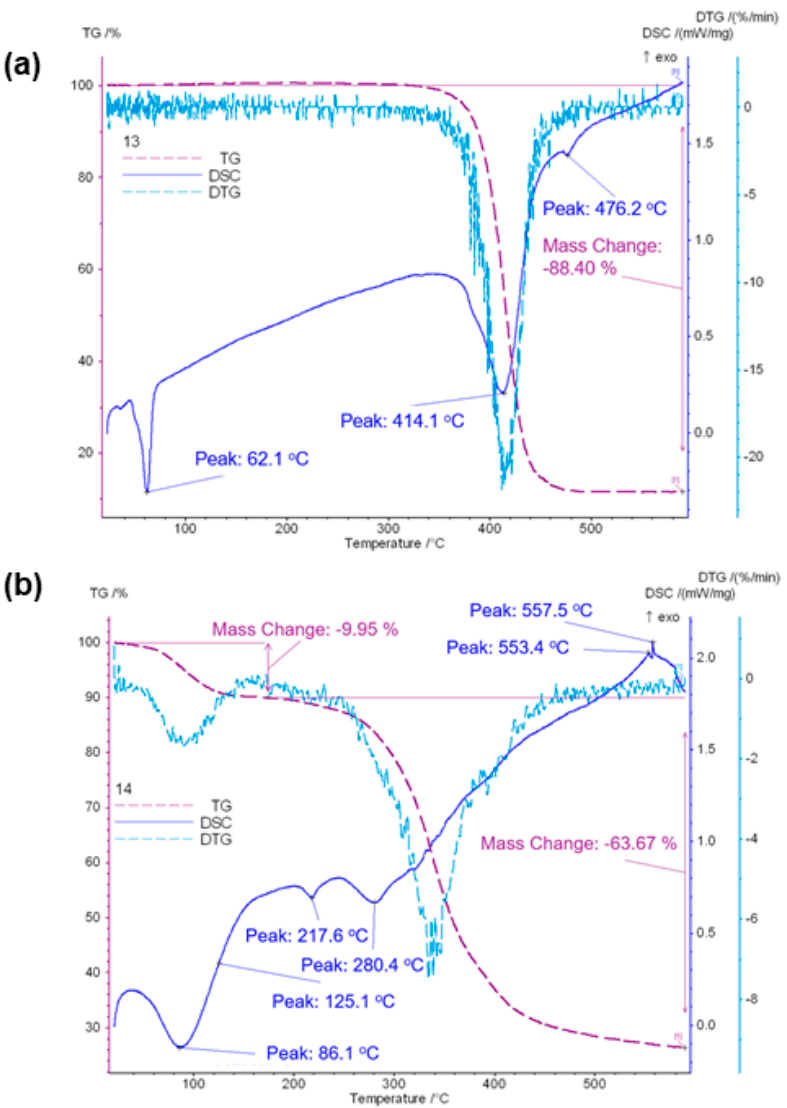
Figure 3. DSC, TG, DTG thermograms of PCL/n-HAp ( a ) and PCL/n-HAp/PANI ( b ) scaffolds.